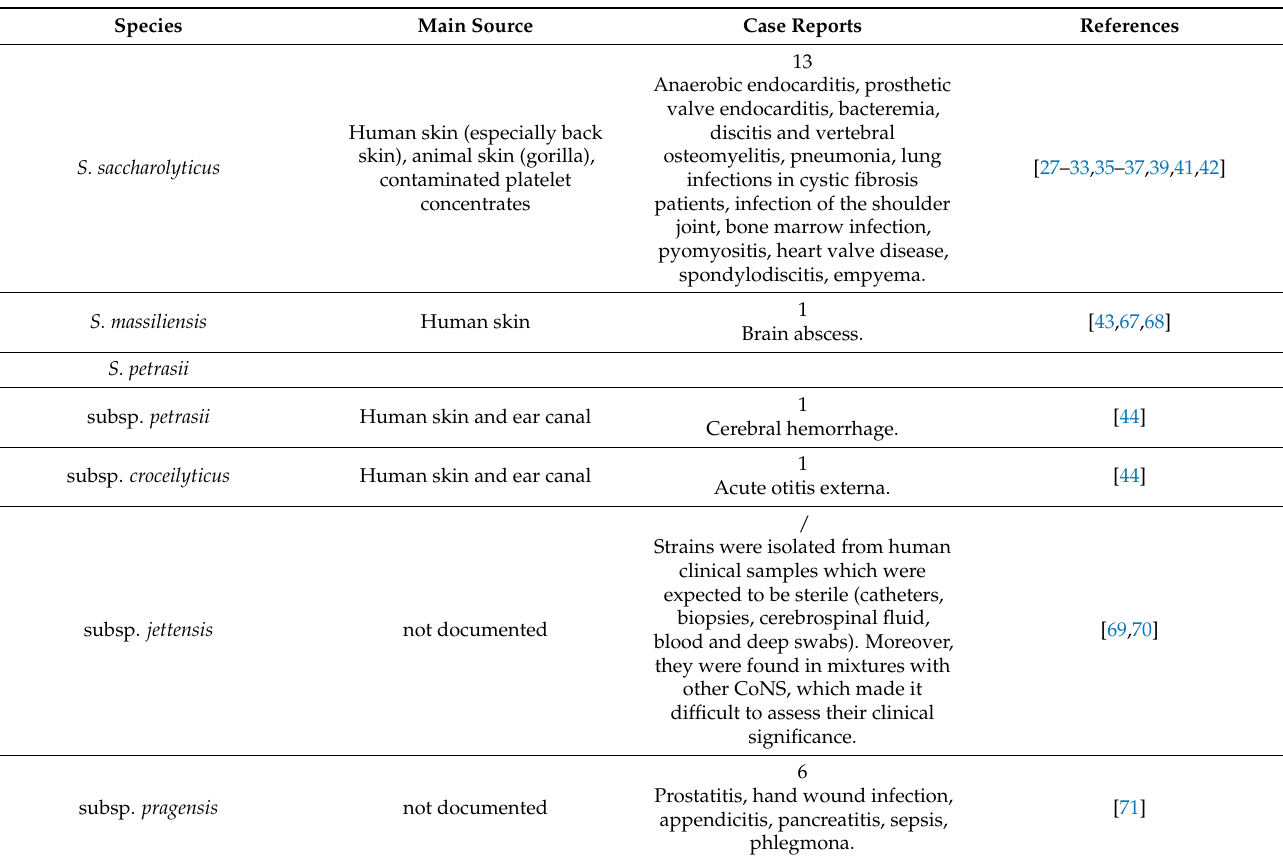
Table 1. Detailed clinical information on the cases reported thus far with S . saccharolyticus , S . massiliensis , and the different S . petrasii